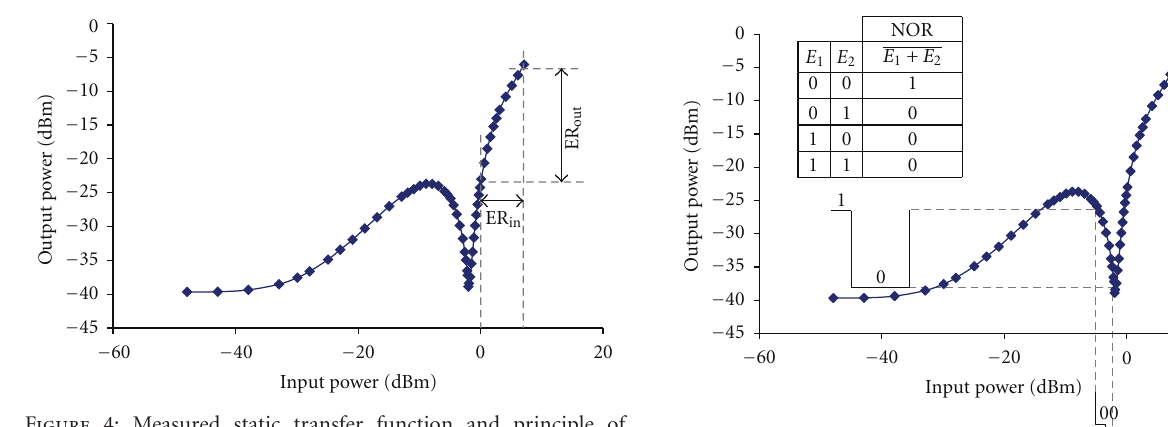
Figure 4: Measured static transfer function and principle of operation for 2R optical regeneration at a blocking power equal to − 2dBm and wavelength equal to 1550 nm.